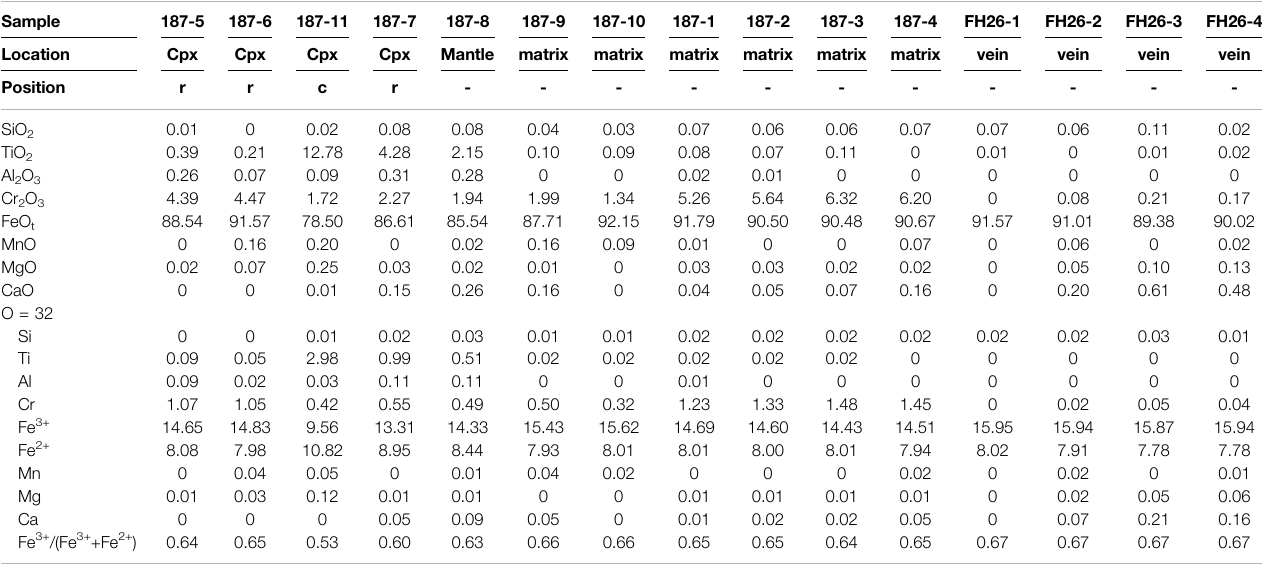
TABLE 3 | Major element abundances (wt%) of magnetites (c: core; r: rim). Sample